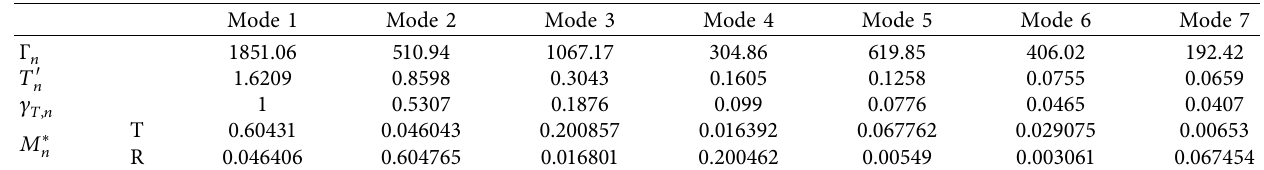
Table 8: Calculation of D